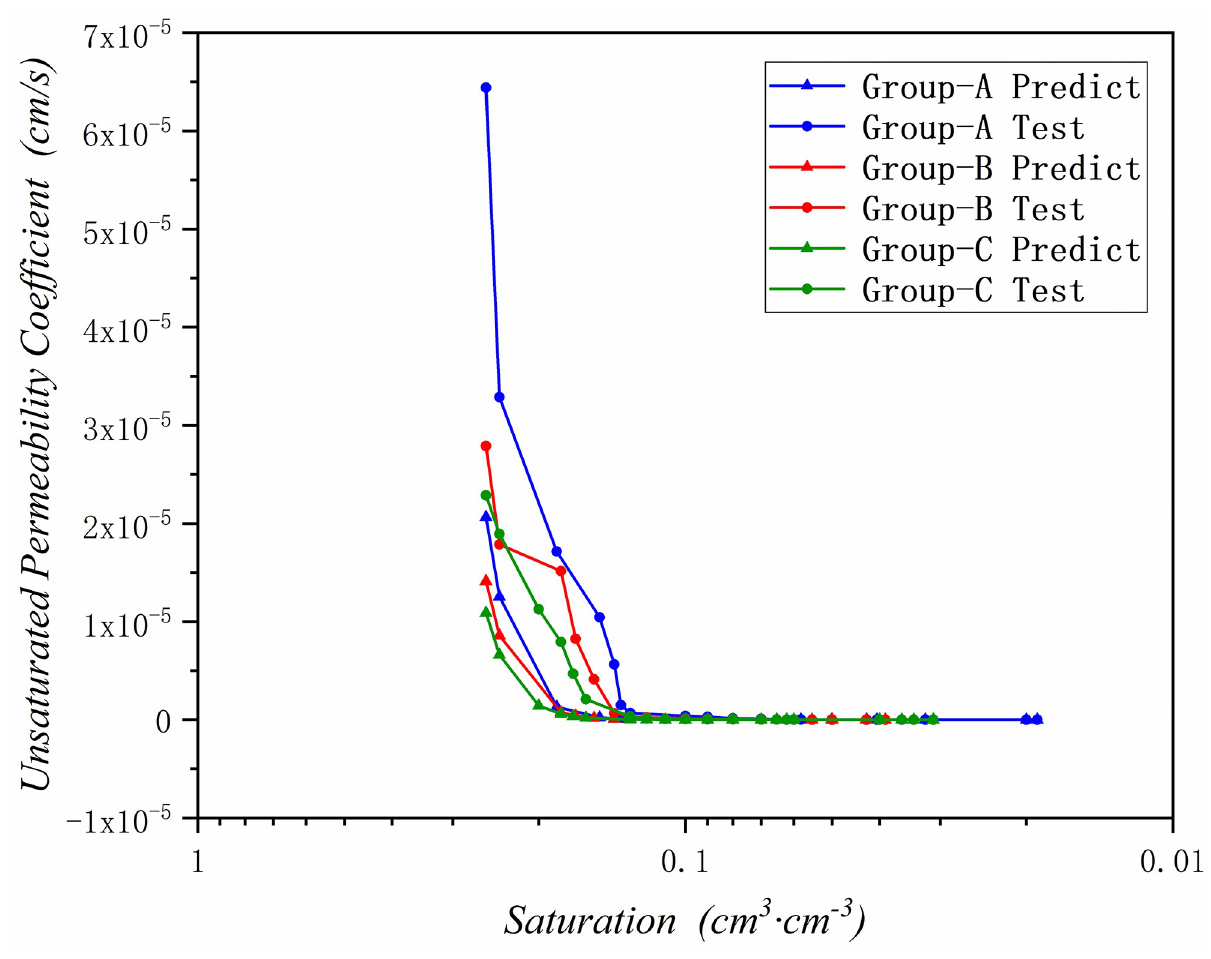
Fig 10. The predicted unsaturated permeability coefficient graph in Zone